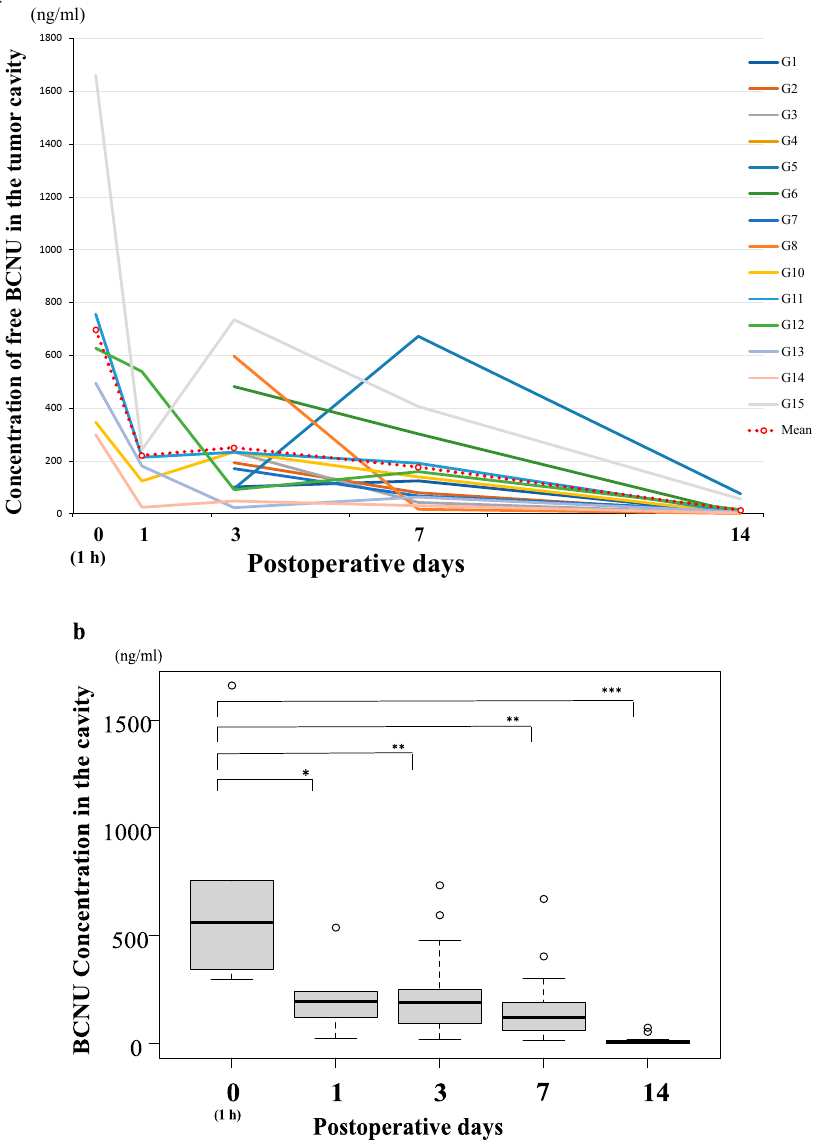
Figure 1. Time course of the bis-chloroethyl nitrosourea (BCNU) concentration (days 0–14) in the tumor resection cavity in 14 patients with malignant glioma treated with BCNU wafers. ( a ) The con- centration curves of BCNU showing the sampling data of 14 patients. The mean BCNU concentration at each sampling time was calculated and presented in the graph (red dotted line). ( b ) Time course of the median BCNU concentration shown in box plots represented as horizontal bars, as well as the 5th and 95th percentiles. The BCNU concentration was the highest (mean/median (Mn/Md): 697/560 ng/mL) at day 0 (1 h), rapidly decreased to 220/196 (Mn/Md) ng/mL within 24 h, was maintained at more than 176/124 (Mn/Md) ng/mL for 7 days, and decreased to an almost unde- tectable level at 14 days after implantation. The concentration of BCNU at day 0 was significantly higher than that at day 3, day 7, and day 14 (* p < 0.01, ** p < 0.001, *** p <